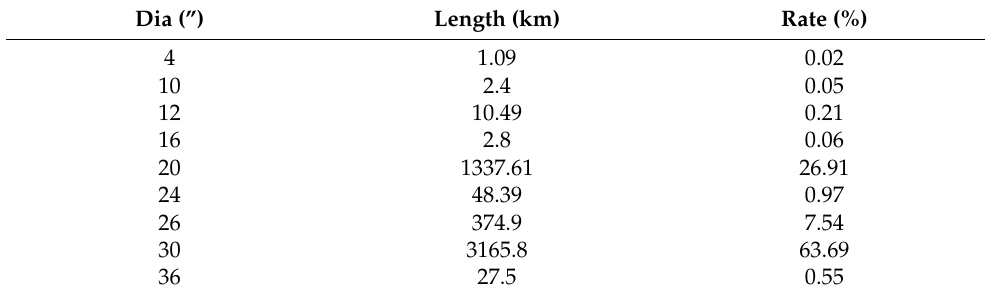
Table 1. Current status of natural gas main pipelines by diameter in Korea [21].